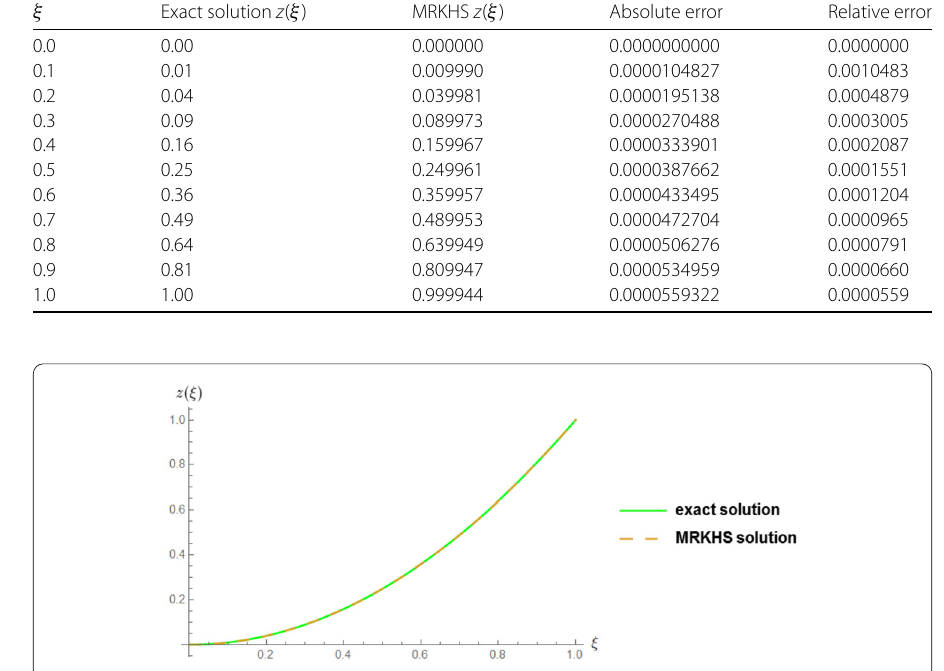
Figure 3 Exact and MRKHS solution curves of Example